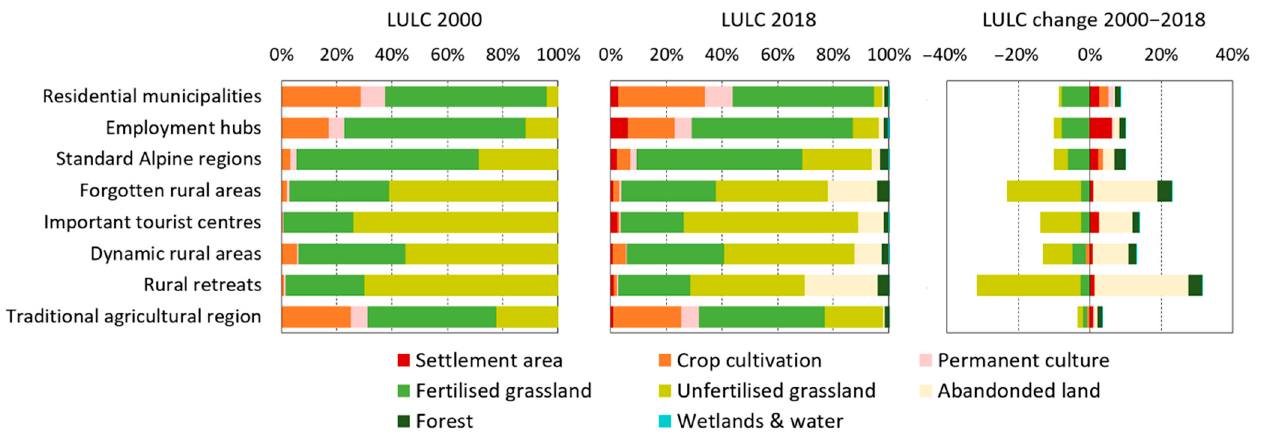
Figure 3. LULC distribution across eight social–ecological regions in the European Alps in 2000 ( left ) and 2018 ( center ), as well as LULC changes between 2000 and 2018 ( right ), only referring to the area that was covered in 2000 by agricultural LULC types (i.e., crop cultivation, permanent culture, fertilized grassland, and unfertilized grassland). Wetlands, rivers, lakes are summarized as ‘wetlands & water’. Authors own elaboration.